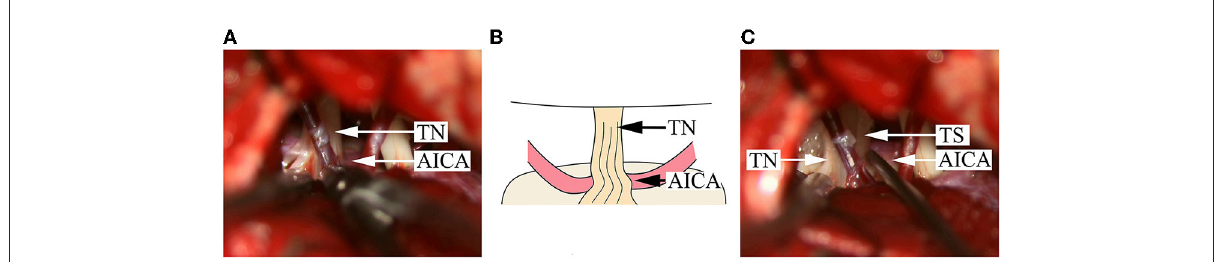
FIGURE1 Intraoperative findings in a DR patient with compression from a single offending artery on the root entry/exit zone. (A) An AICA is identified; the NVC is located on the ventral side of the TN REZ; the color of the nerve root on the dorsal side becomes bright and is uplifted and distorted